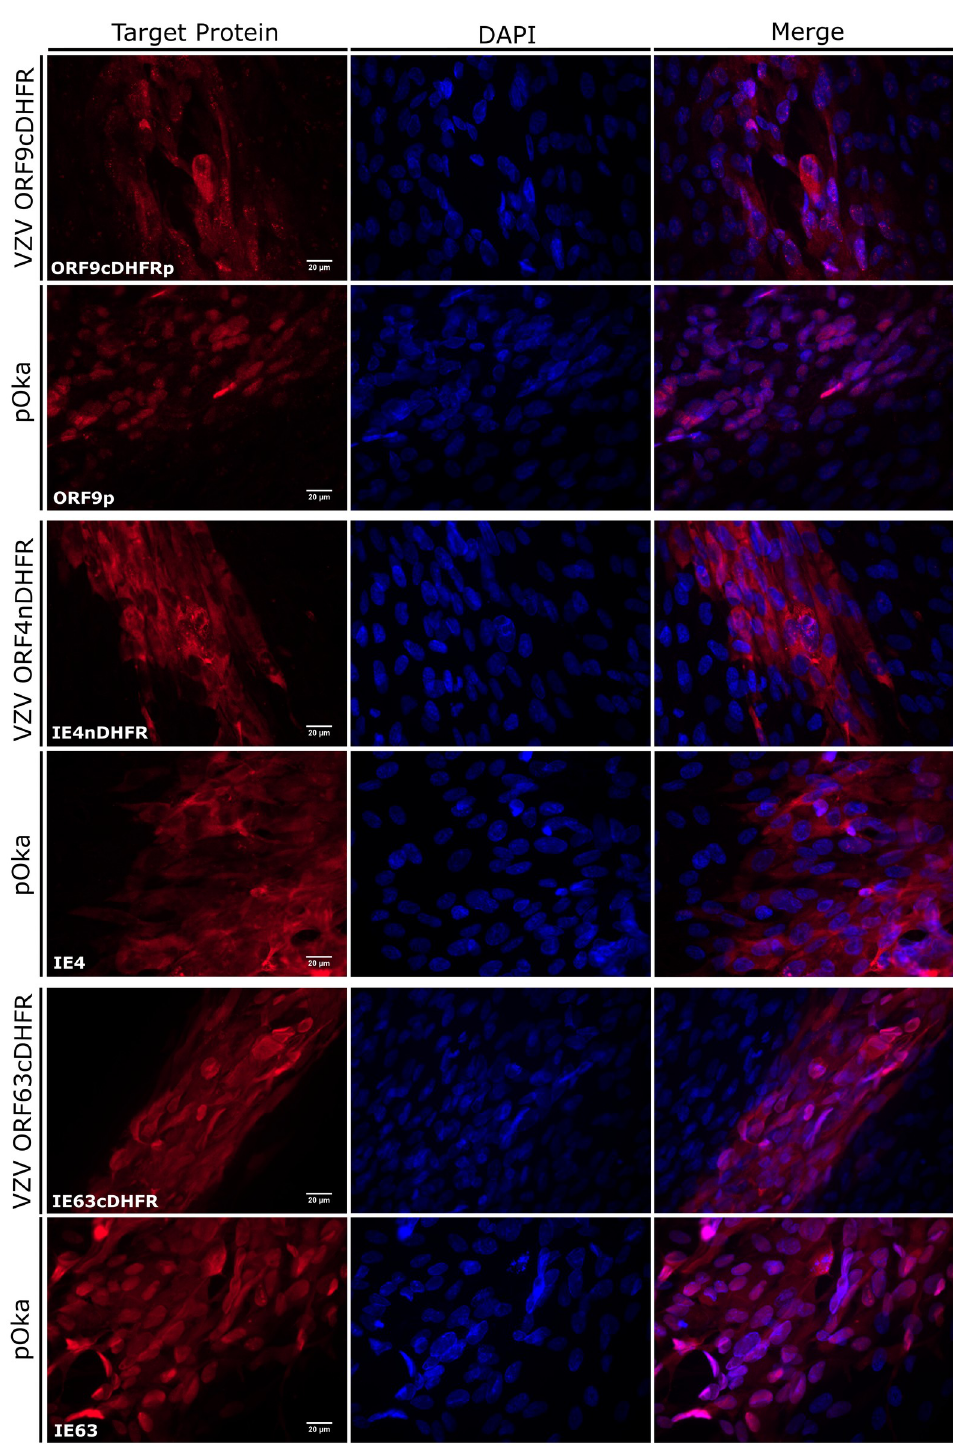
Fig 6. Localization of degron fused viral proteins compared to wild-type VZV proteins in infected cells. (A) Images show the edges or small regions of plaques formed by wild-type VZV (pOka), VZV ORF9cDHFR (top), VZV ORF4nDHFR (middle), or VZV ORF63cDHFR (bottom) at 2-dpi. Protein cellular distribution in fixed cells was imaged to represent the distribution seen in the cultures after staining with antibodies to ORF9p, IE4, or IE63. The ‘target protein’ column indicates the specific protein probed, as noted in the lower left corner of the column. The center column shows DAPI stained nuclei, and the rightmost column shows a merged panel of target protein